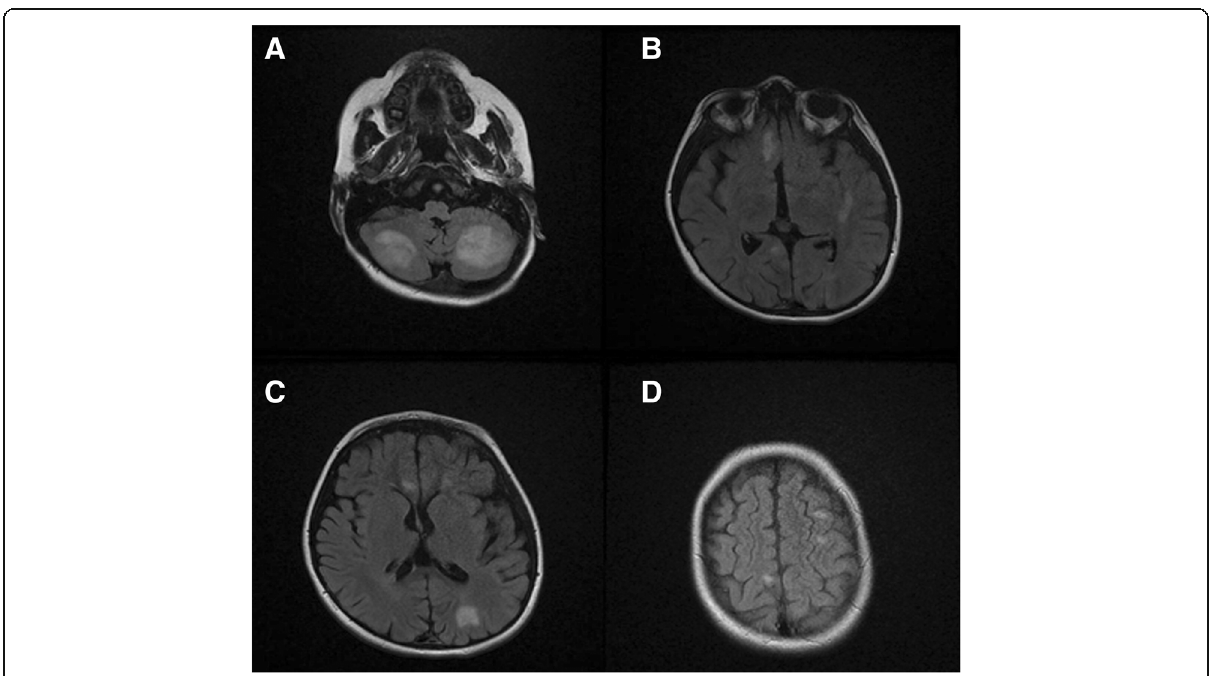
Fig. 1 a , b , c and d Axial Flair sequences of brain MRI, which reveal numerous variable size and irregular shape hypersignal areas involving cerebral hemispheres, cerebellar hemispheres, pones and cerebral peduncles, mostly located in the corticomedullary junction and deep white matter in favor of HLH CNS involvement